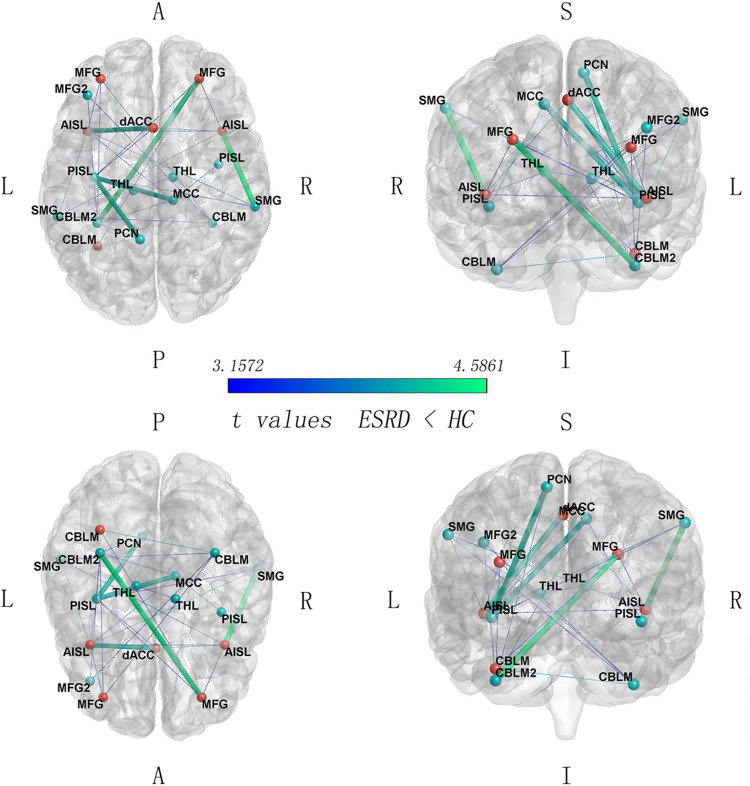
Between-group comparison on SN connectivity (ESRD < HC, FWE corrected p < 0.05). Red nodes, the anterior SN regions; green nodes, the posterior SN regions. SMG, supramarginal gyrus; CBLM, cerebellum_6; CBLM2, cerebellum_6(2); MFG, middle frontal gyrus; MFG2, middle frontal gyrus (2); AISL, anterior insula; PISL, posterior insula; PCN, precuneus; THL, thalamus; MCC, middle cingulate cortex; L, left; R, right; A, anterior; P, posterior; S, superior; I, inferior. The five thicker edges represent the FC links with the 20% of t values.